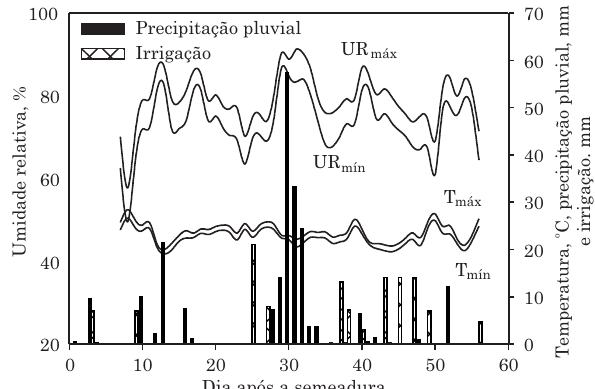
Figura 1. Variáveis meteorológicas e irrigação no período da semeadura até o enchimento das vagens da cultura do feijoeiro (30/01 a 26/03 de 2008). UR máx : umidade relativa do ar